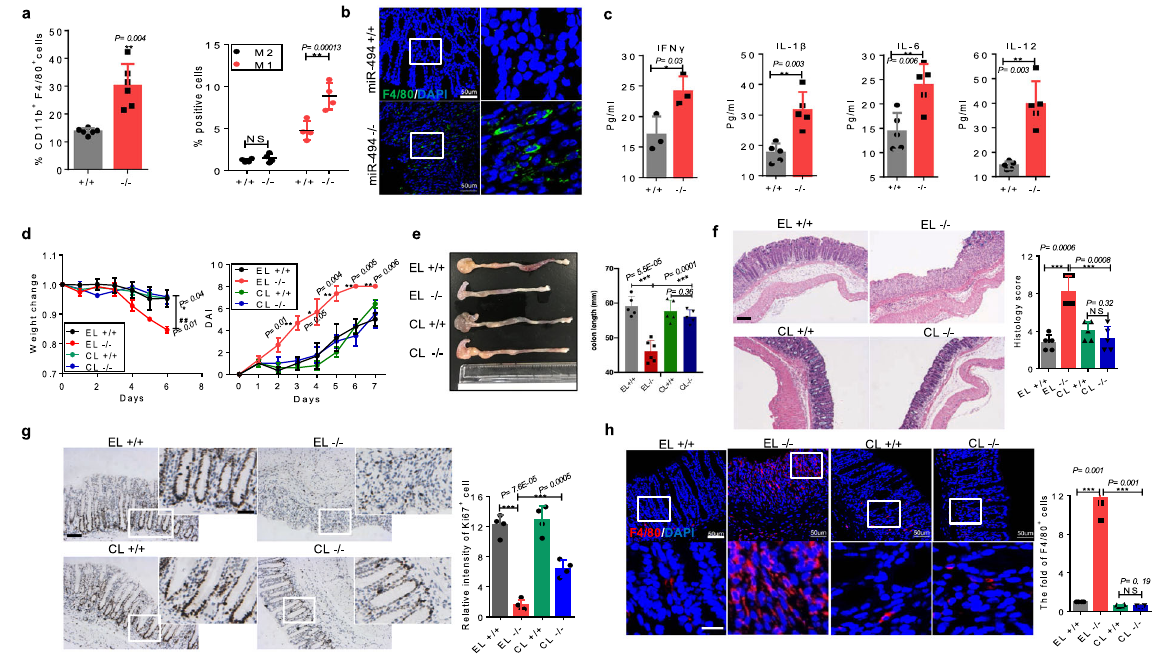
Fig. 4 LP macrophages contribute to increased in fl ammation of DSS-treated miR-494 − / − mice. a Subpopulations of colonic LP macrophage (gated for CD11b + CD11C - F4/80 + cells), M1 (gated for CD11b + CD11C - F4/80 + CD206 − cells) and M2 (gated for CD11b + CD11C − F4/80 + CD206 + cells) subsets were analyzed from miR-494 − / − and WT ( + / + ) mice on day 7 after DSS treatment. b IF staining of colon tissues for macrophage marker F4/80 on day 7 after DSS treatment. Scale bar: 50 μ m. c The protein levels of each indicated cytokines were determined by ELISA in plasma from miR-494 − / − mice and WT mice on day 7 after DSS treatment. d – h Mice were provided with free access to 3% DSS in drinking water for 7 days, and empty liposomes (EL) or clodronate liposomes (CL) was administrated by ip (200 μ l/mice) at days − 4, 0, 2, 4, and 6. Day 0 is the initial time point of DSS treatment. d Body weight changes and DAI of the indicated miR-494 − / − mice and WT mice after DSS treatment in macrophage deletion assay. e Colon length was measured on day 7 after DSS treatment. f Typical images of H&E staining of colon tissues, and histological score (0 – 12), scale bar: 200 μ m. g IHC staining of colon tissues on day 7 after DSS treatment for proliferation marker Ki67 and the quanti fi cation of Ki67 + cells. Scale bar: 100 μ m, scale bar of close-up image: 50 μ m. h IF staining of colon tissues on day 7 after DSS treatment for macrophage marker F4/80 (scale bar: 50 μ m, scale bar of close-up image: 10 μ m) and quanti fi cation of the number of F4/80 + cells. Data are presented as mean ± S.D. and analyzed by non-paired two-tailed Student ’ s t- test in the graphs in ( a , c , d – h ). *** P ≤ 0.001; ** P ≤ 0.01; * P ≤ 0.05; NS, no signi fi